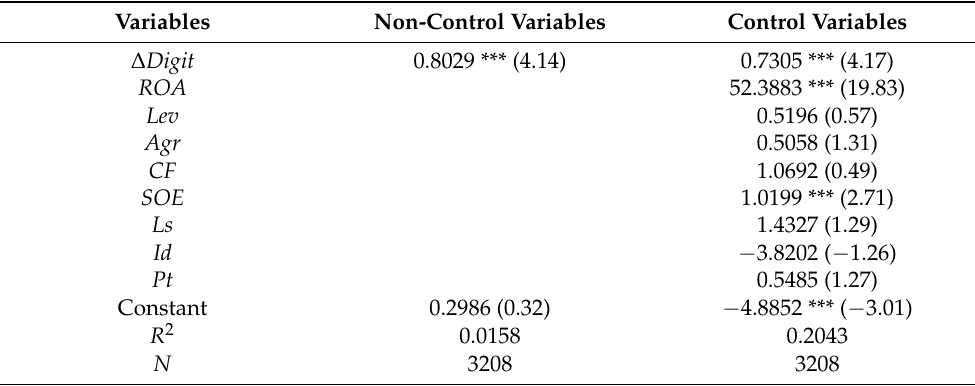
Table 8. Regression Results of First Difference